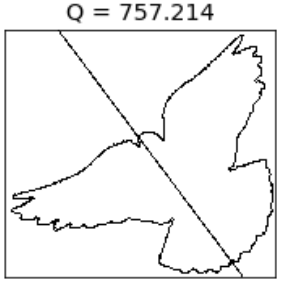
Figure 2. A bird unsymmetrical contour. Q is the asymmetry